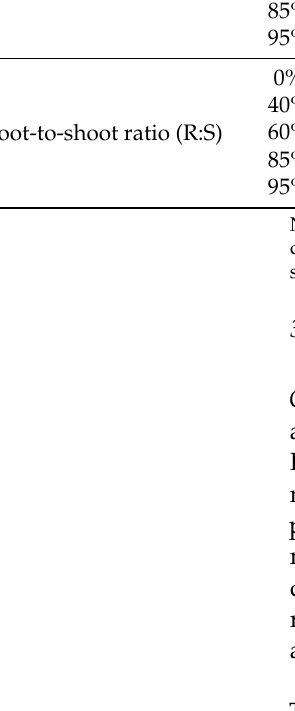
Table 4. Phenotypic plasticity index of traits in five tree species under different shade